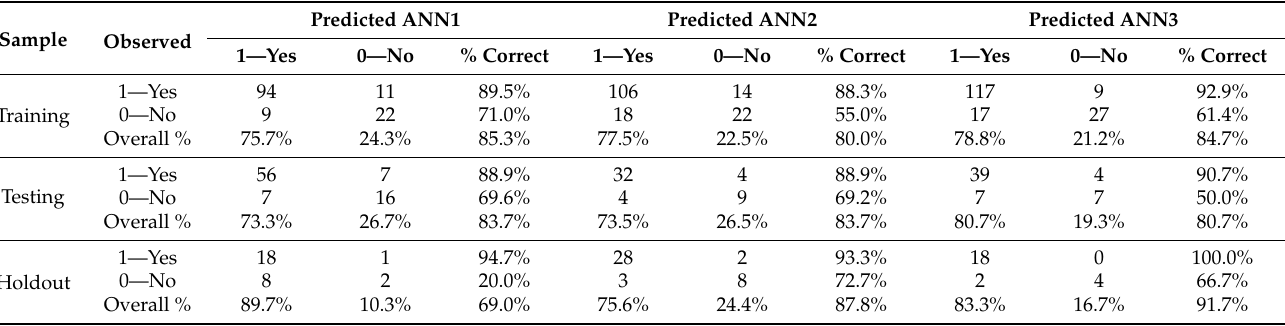
Table 5. ANNs’ classification matrices.